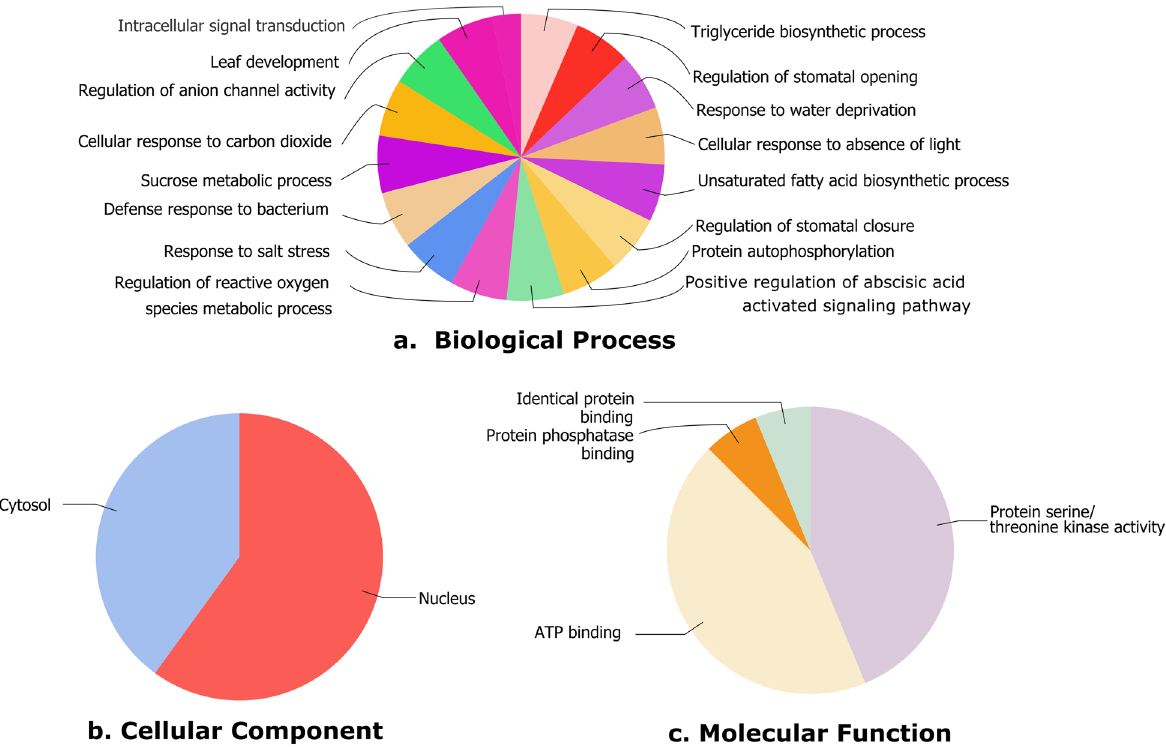
Fig. 5 Gene ontology of CoSnRK2 and CcSnRK2 proteins biological process ( a ). Cellular components ( b ). Molecular function ( c